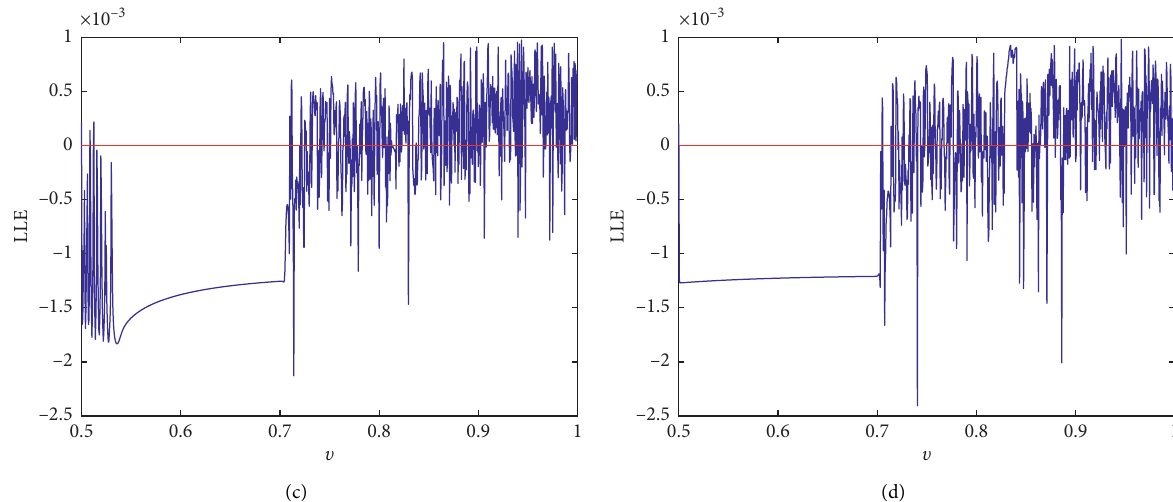
Figure 8: Bifurcation diagrams and corresponding LLE spectrums for the map with different initial values as the order υ varies: (a) the bifurcation diagram with x , (b) the bifurcation diagram with x 01